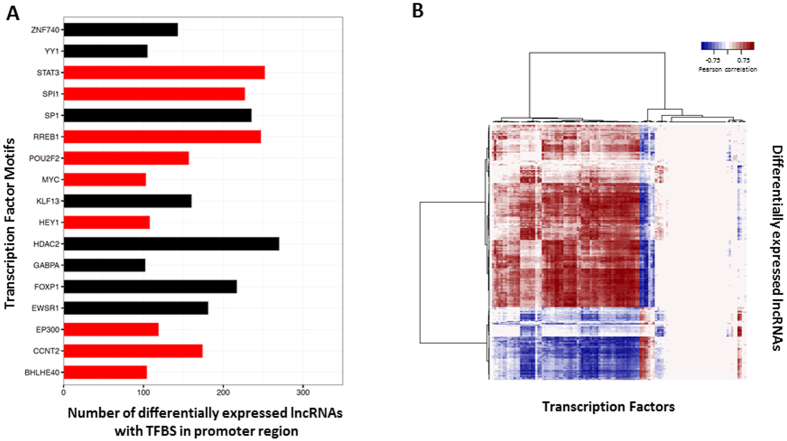
TF motifs found in the upstream regulatory regions of DE lncRNAs.(A) TFs with binding motifs found in more than 100 DE lncRNA regulatory regions. The x-axis indicates the number of DE lncRNAs containing binding motifs for particular TFs. DE TFs are shown in red and non-DE TFs in black. (B) Expression correlation matrix between DE lncRNAs and TFs with at least one motif in the upstream regulatory regions of DE lncRNAs. The matrix is colored-coded by Pearson correlation coefficients: color depth represents the correlation strength; red indicates positive correlation and blue indicatives negative correlation. The numerical correlation matrix is included in Supplementary Table S11.